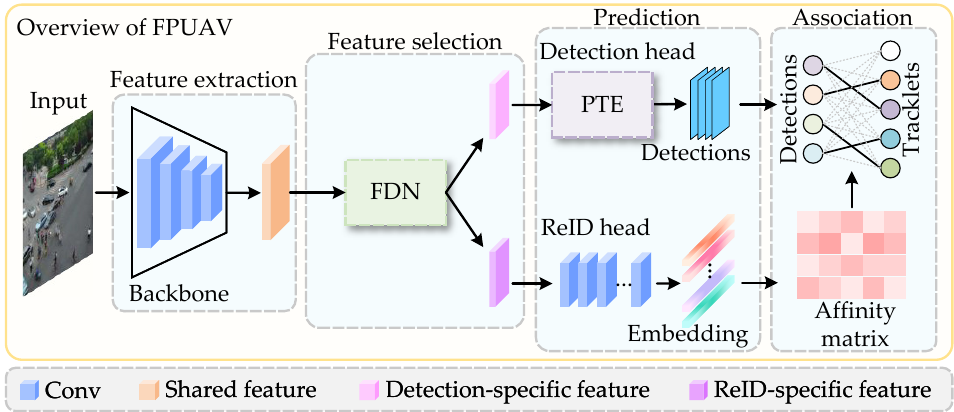
Figure 2. The architecture diagram of the